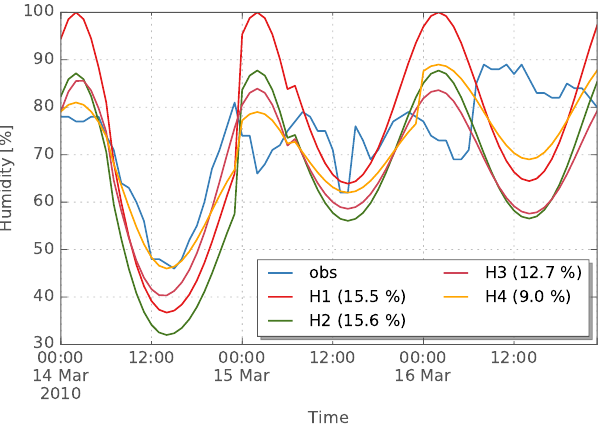
Figure 3. Example application of the temperature disaggregation model T1 performed with different settings for Obergurgl. Observed and disaggregated time series are shown for temperature. T1a: fixed abscissa values for minimum and maximum temperature; T1b: min- imum and maximum temperature are related to sunrise and sun noon + 2h, respectively; T1c: similar approach as T1b with an addi- tional empirical shift of the maximum temperature; T1d: option T1a with modified nighttime option. The numbers in parentheses indi- cate the root mean square error (RMSE) computed for each method.